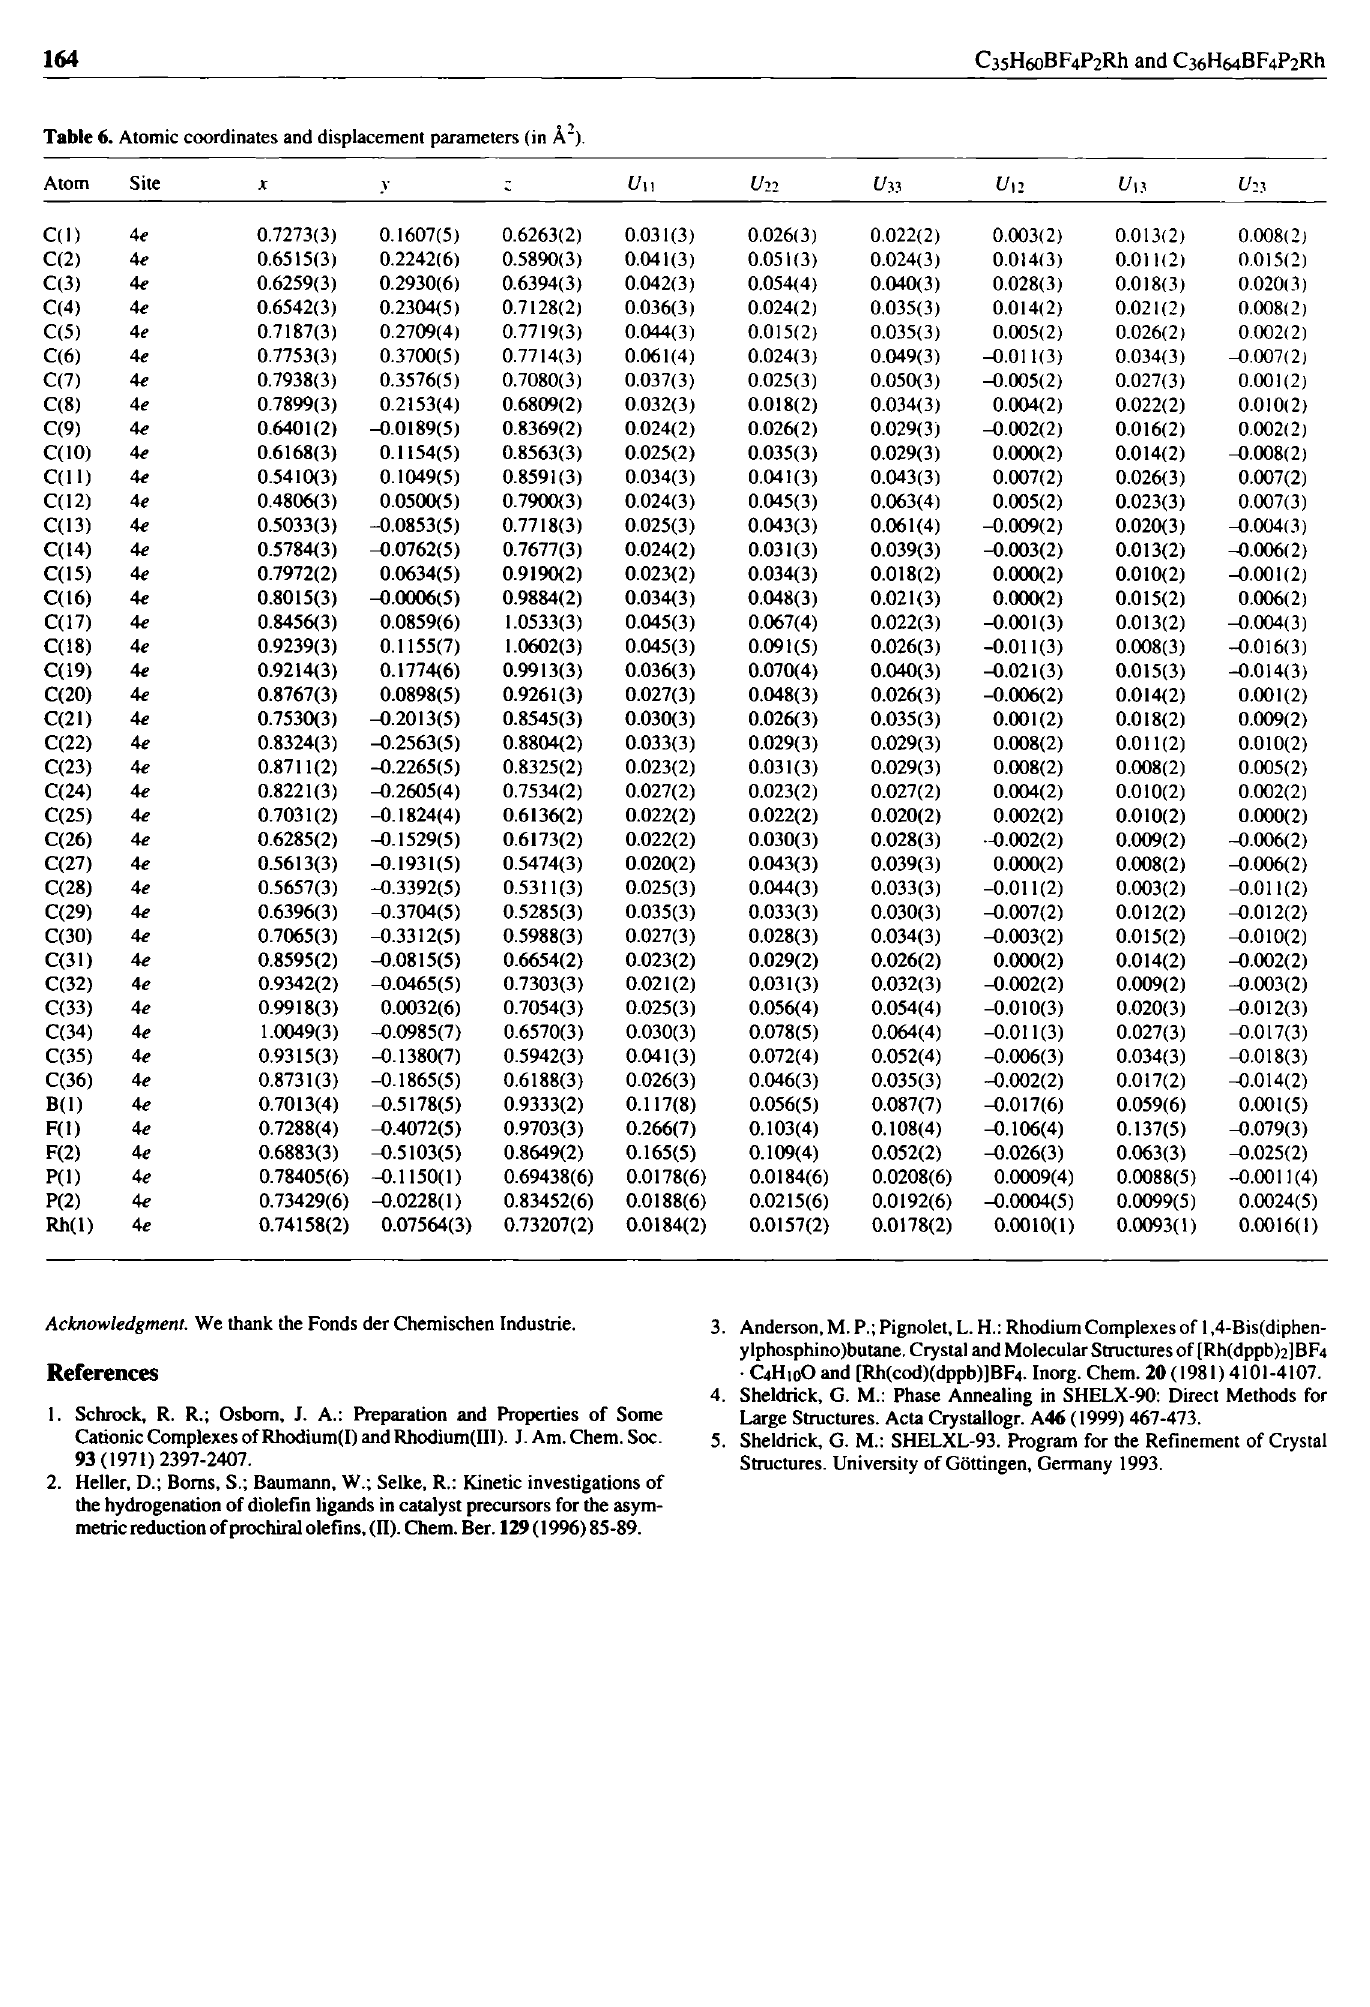
Table 6. Atomic coordinates and displacement parameters (in A 2